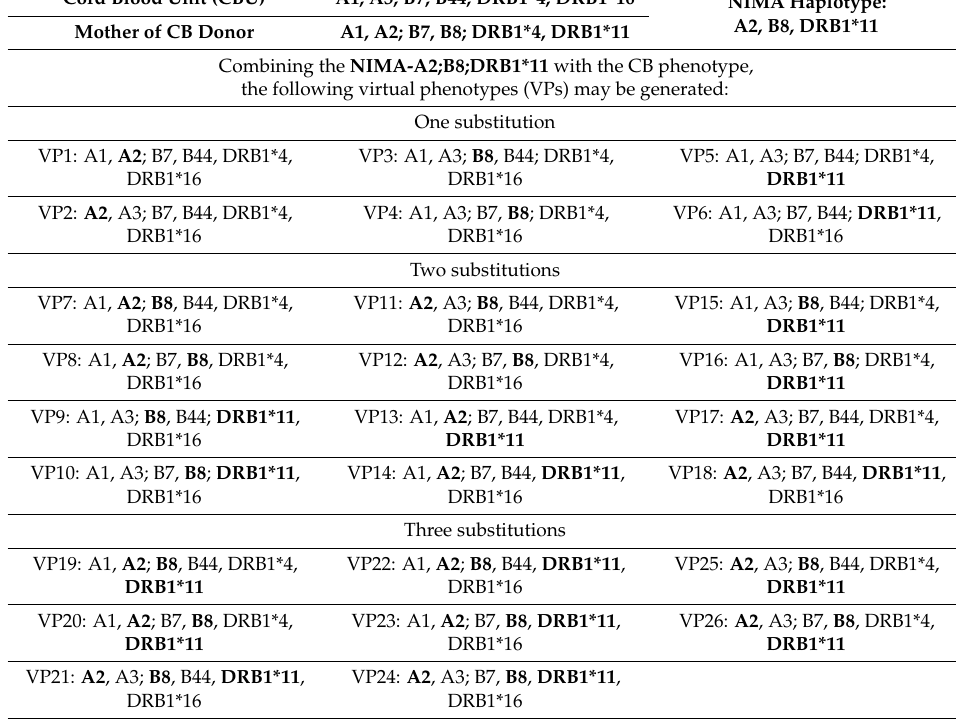
Table 1. Virtual human leucocyte antigen (HLA) phenotypes, created with the contribution of non-inherited maternal antigens (NIMA). Bold text indicates understanding how NIMA haplotype yields to 26 different HLA